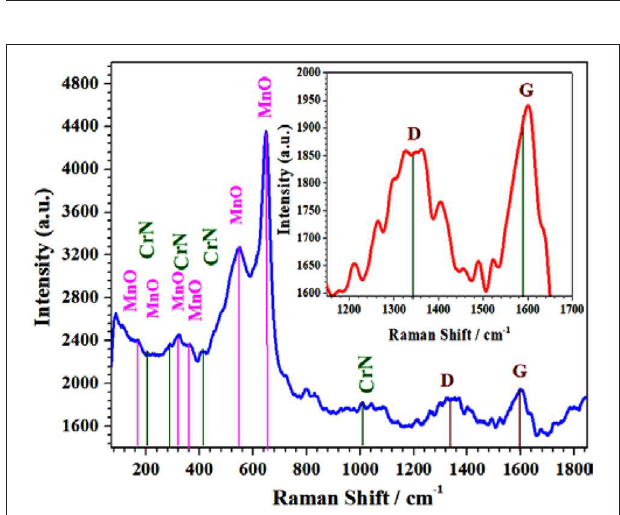
FIGURE 4 | Raman spectra of Cr/rGO composite with MnO. rGO, reduced graphene oxide.